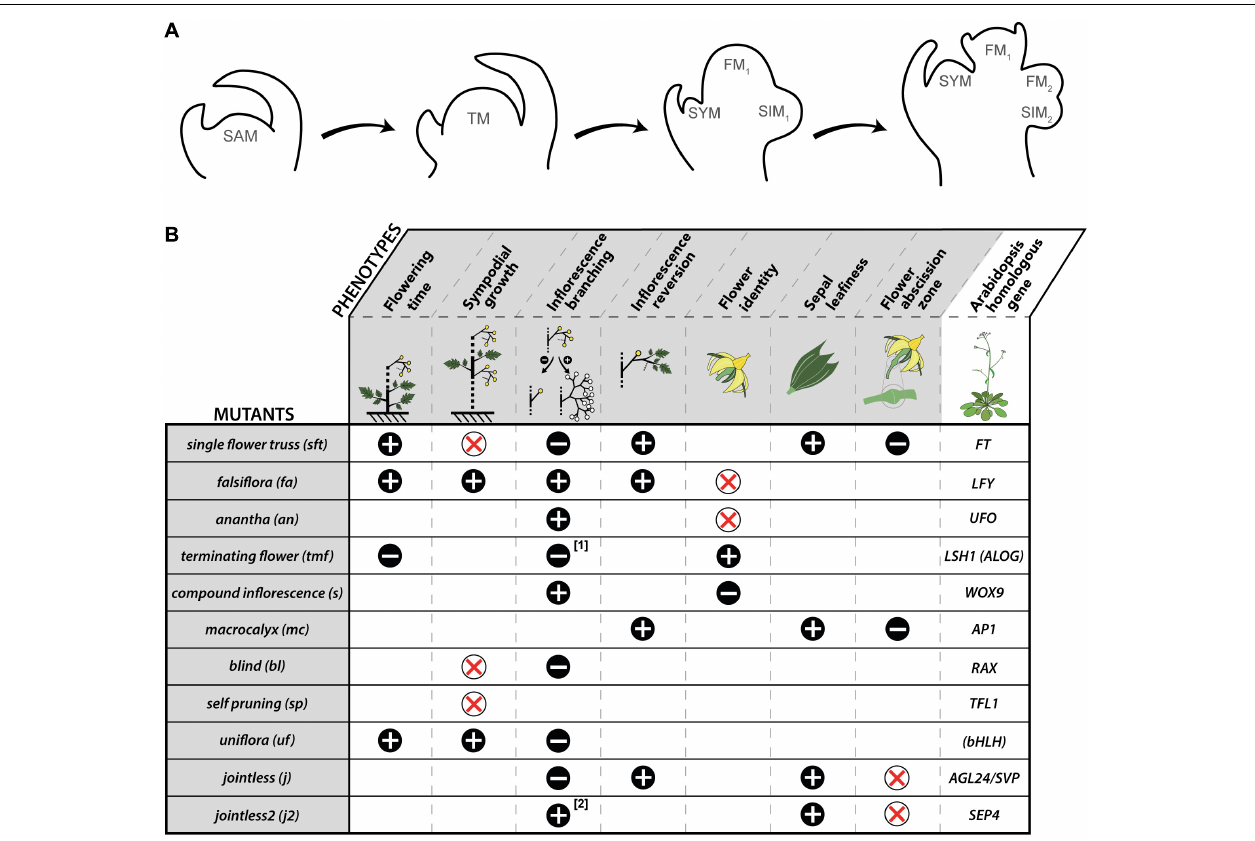
FIGURE 1 | Inflorescence formation in tomato and phenotypic traits of mutants showing flowering time, sympodial growth, or inflorescence abnormalities. (A) Steps of inflorescence formation: (1) pre-transition vegetative shoot apical meristem (SAM); (2) transitional meristem (TM); (3) start of inflorescence branching: the first flower meristem (FM 1 ) is developing while a sympodial inflorescence meristem (SIM 1 ) appears laterally; the vegetative meristem at the axil of the youngest leaf is the shoot sympodial meristem (SYM) that takes over shoot growth; (4) the first flower is reaching the sepal initiation stage, while SIM 1 has formed the second flower meristem (FM 2 ) and the second SIM (SIM 2 ). (B) Phenotypic traits of tomato mutants. “+” means that the phenotypic trait is increased; “–” means that the phenotypic trait is decreased, “x” means that the phenotypic trait is suppressed. The mutants are listed in their order of appearance in the text where relevant references can be